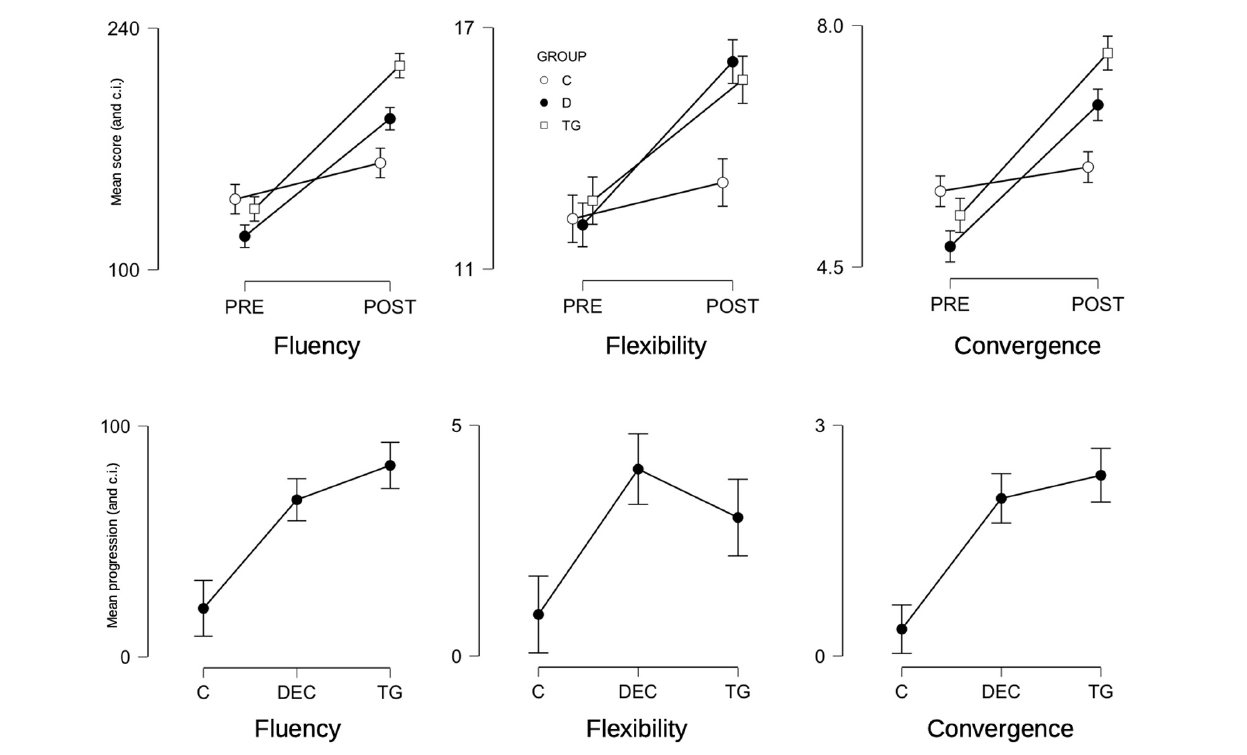
FIGURE 3 | Top row: graphs of interactions between the GROUP and PRE/POST factors on the FLU, FLEX, and CONV variables (and confidence intervals). Bottom row: effect of the GROUP factor on the progression of the FLU, FLEX, and CONV variables (and confidence intervals) between the PRE and POST